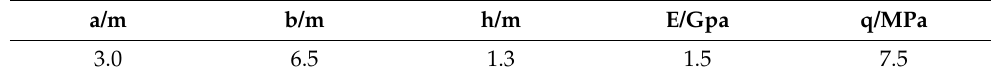
Table 1. Main calculation parameters.